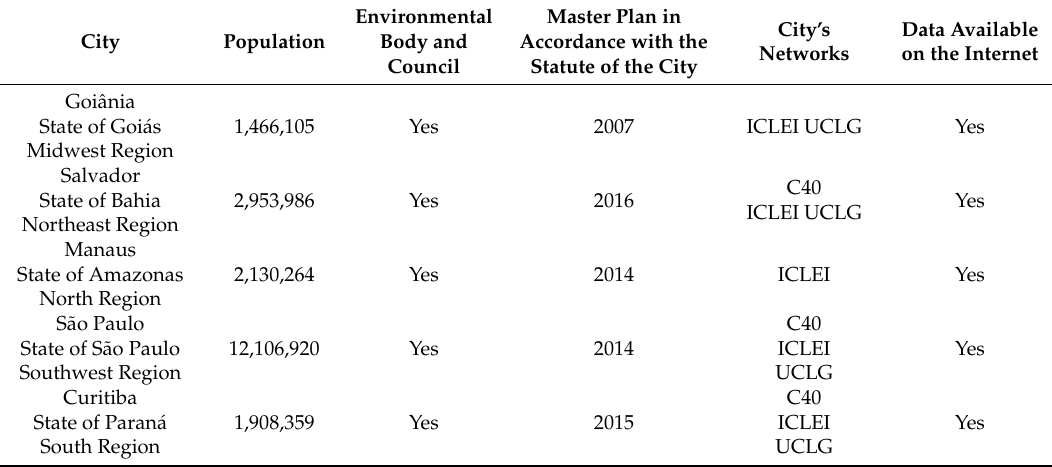
Table 1. Case study cities’ salient